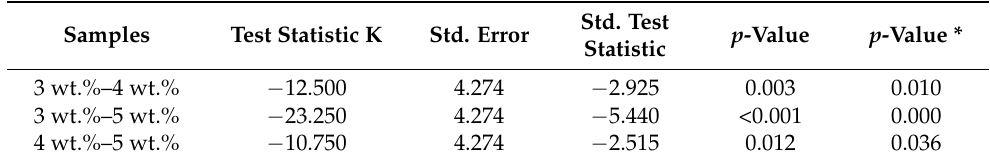
Table 4. Pairwise comparison results using Dunn’s nonparametric post-hoc Table 3. Independent samples Kruskal–Wallis test summary.